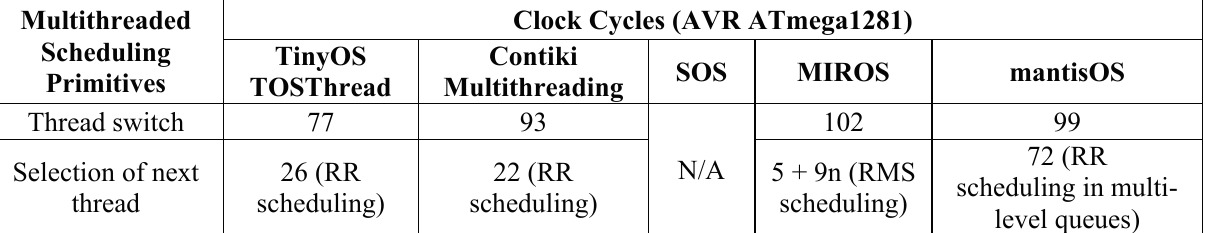
Table 3. Clock cycles of the thread switch and thread selection primitives in different schedulers. Multithreaded